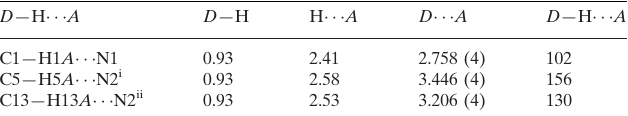
Hydrogen-bond geometry (A˚ , (cid:2)